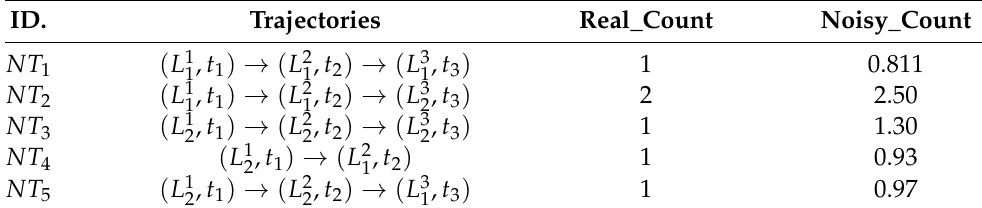
Table 2. Noisy trajectory records.